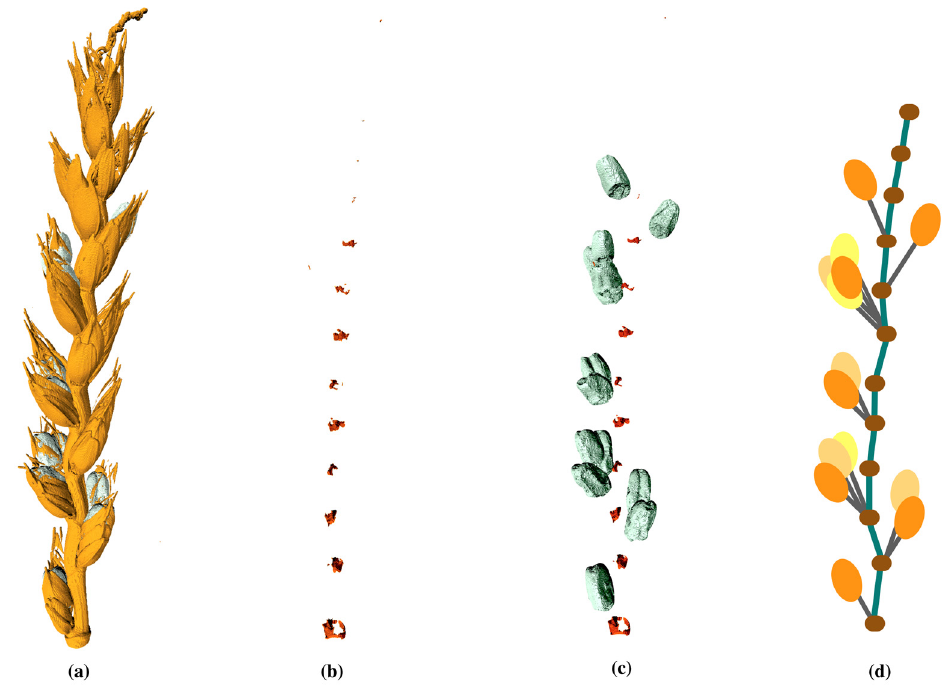
Figure 15. Stem detection and grain angle computation. ( a ) 3D images of a wheat spike; ( b ) Detected stem by 3D morphology; ( c ) Combined stem nodes and grains; ( d ) Computed grain angle.